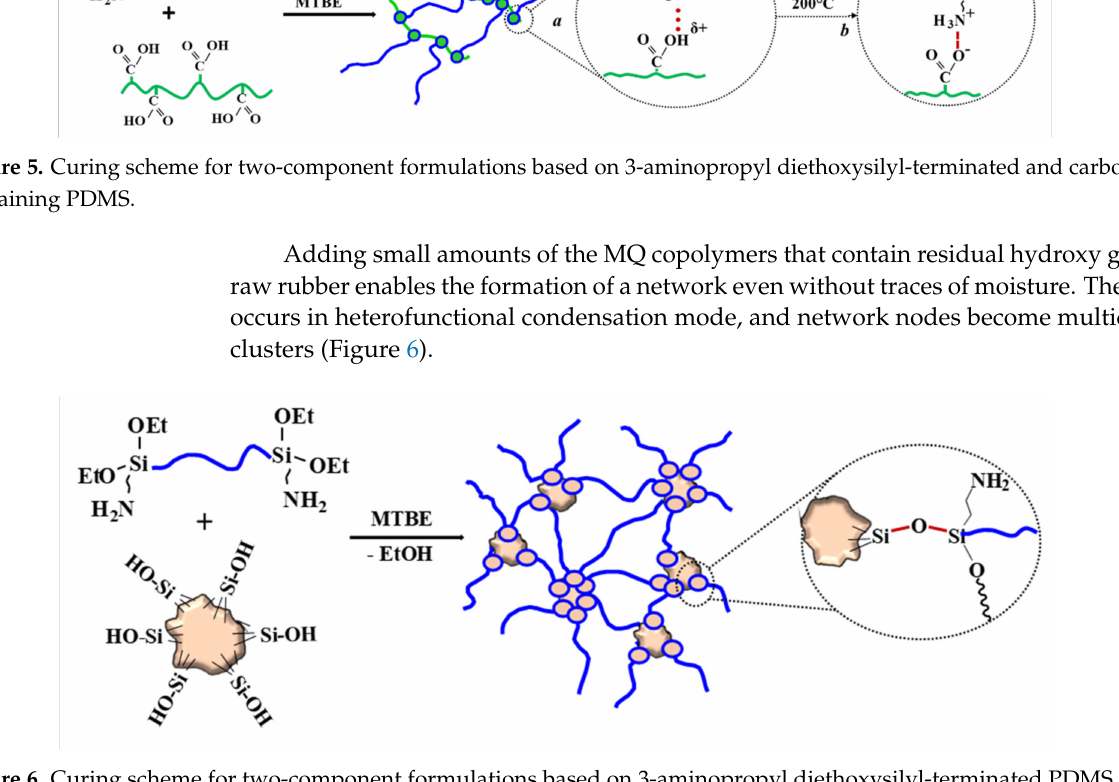
Figure 6. Curing scheme for two-component formulations based on 3-aminopropyl diethoxysilyl-terminated PDMS and MQ